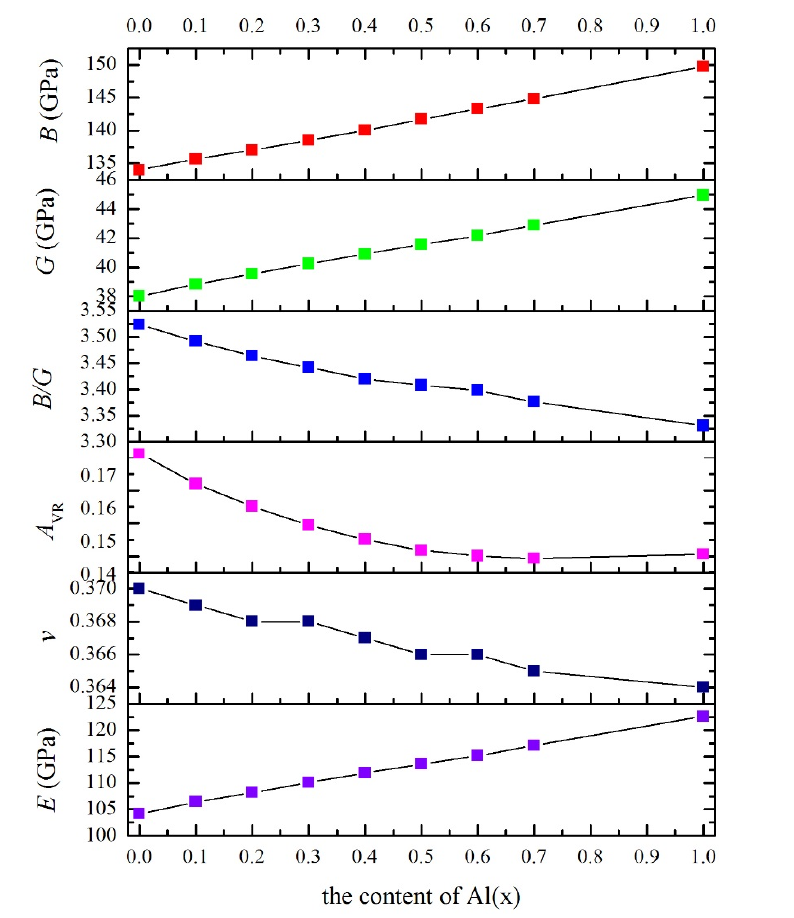
Figure 2. Polycrystalline elastic moduli for Al x Hf 1 − x NbTaTiZr as a function of Al